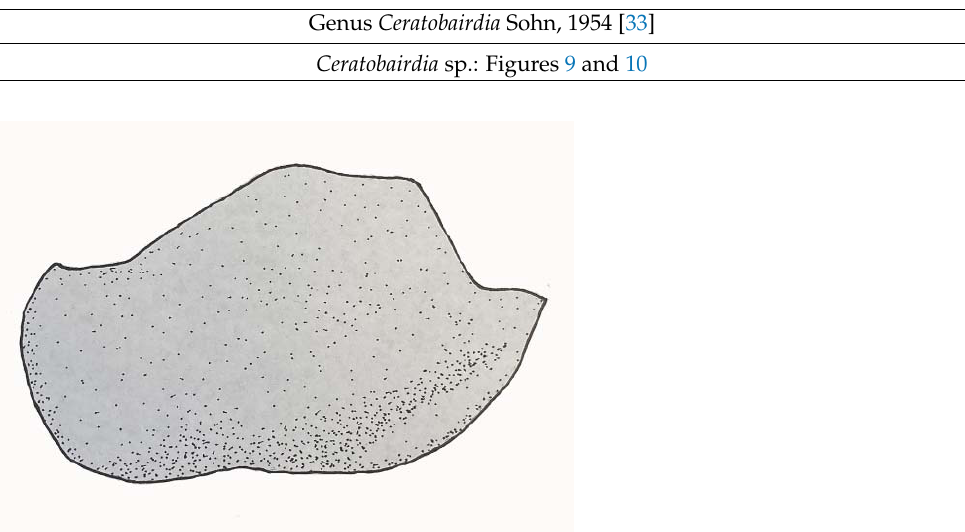
Figure 10. Ceratobairdia sp., right valve, lateral view. IGM 5011(6). Scanning electron micrograph (secondary electrons). Detail of anterior corner spine. Scale bar = 500 microns. Material: One specimen. IGM 5011(6). Field sample ME-8; 41.2 m above the base of the Tin Mountain Limestone. Description: This ceratobairdiid has a relatively short, straight hinge (DB), a steep, straight ADB, a more gently inclined PDB, and a PVB that flares out broadly. The VB is slightly concave. The anterior corner spine (Figure 10) is prominent and broad. The pos- terior corner spine is very broad, and curves gently to a pointed tip. Discussion: This species has the most distinctive profile of all the ostracods reported here from the Tin Mountain fauna, with its trapezoidal DB and inclined dorsal profile. The Tin Mountain specimen bears some resemblance to Ceratobairdia wordensis (Hamilton, 1942 [34]) as illustrated by Sohn [30] but has a slightly concave rather than convex hinge line. Collection data : As for previous. Age and Locality Information : As for previous. Family Bairdiocyprididae Shaver, 1961 [35] Genus Silenites Coryell and Booth, 1933 [36] Silenites sp.: Figure 11